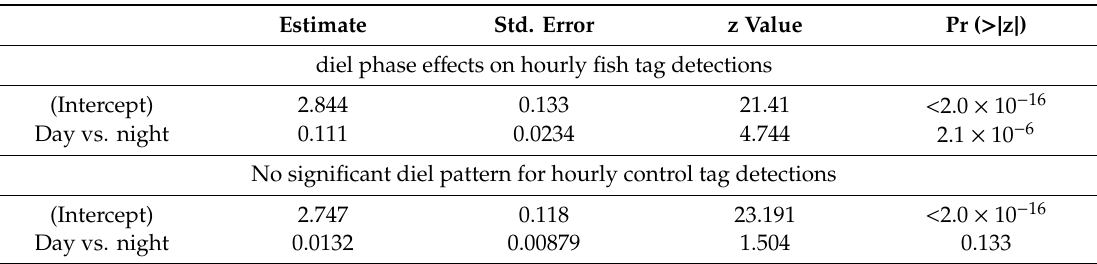
Table 3. GLMM analysis of the e ff ects of diel phase on hourly detections of fish tags and control tags.